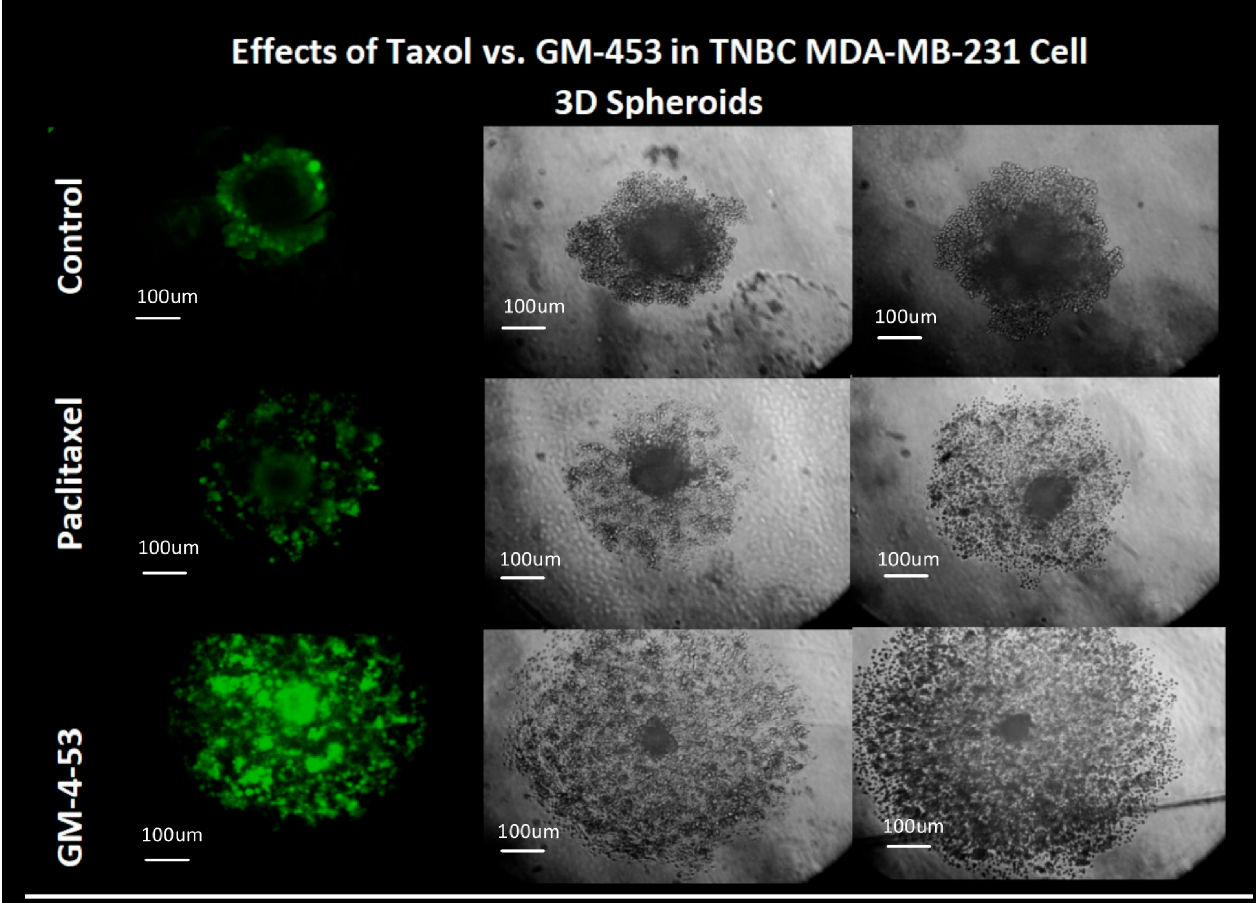
Figure 8. Effect of GM-4-53 (5 µg/mL) and paclitaxel (1 µg/mL) on 3D tumors. The left panel represents cell viability (fluorescein diacetate), and the right 2 panels show basic cell morphology ( n = 2).